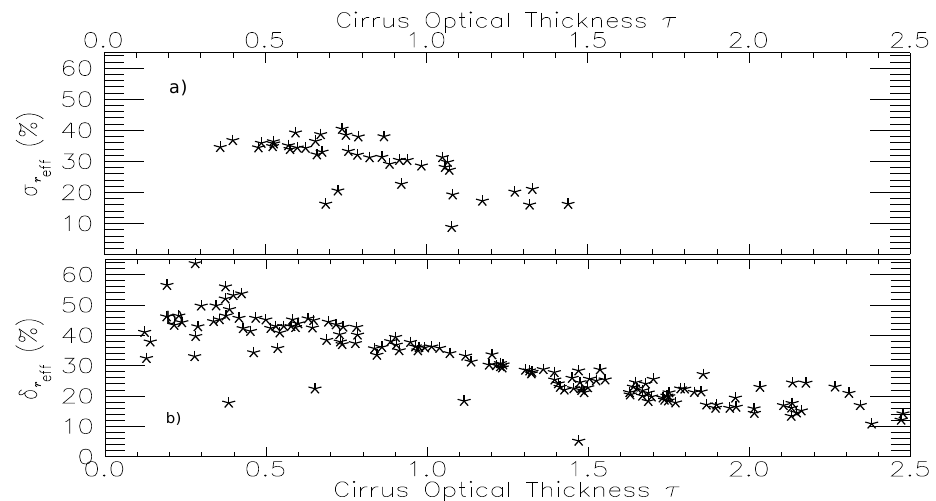
Fig. 16. Comparison of τ retrieved by the HSRL and HALO-SR based surface albedo approach two for 4 November, 2010. For the calculations a parametrization simulating a mixture of ice crystal shapes is used. 26